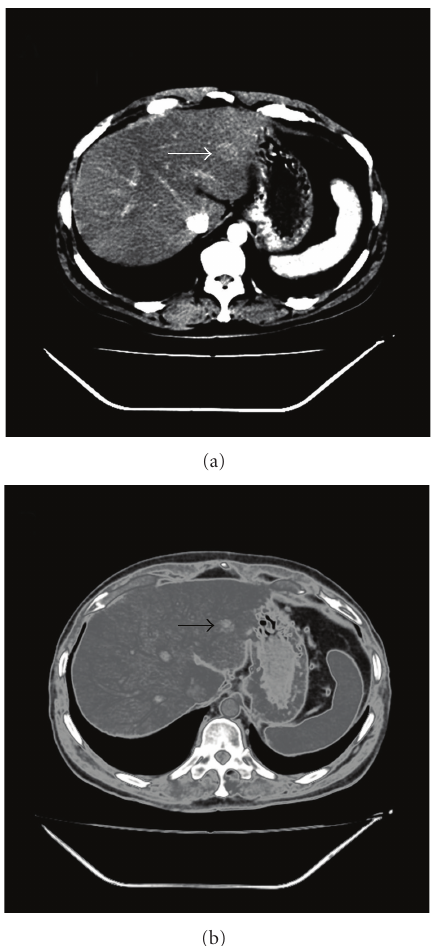
Figure 6: CT showed one lesion in the left lobe liver of case 2 (arrows). (a) contrast enhancement imaging; (b) delayed